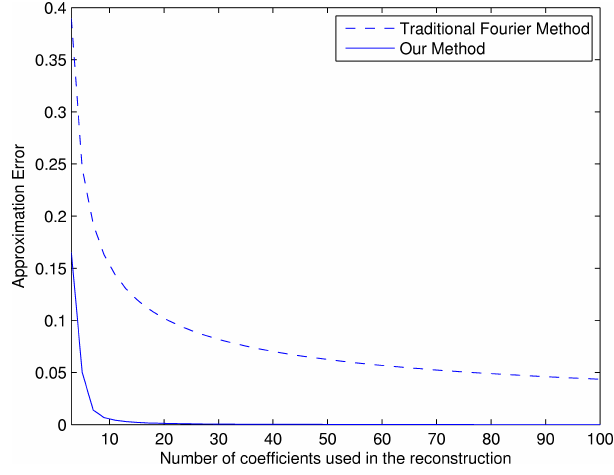
Fig. 1. Approximation of f ( x ) = e x by traditional Fourier method and our